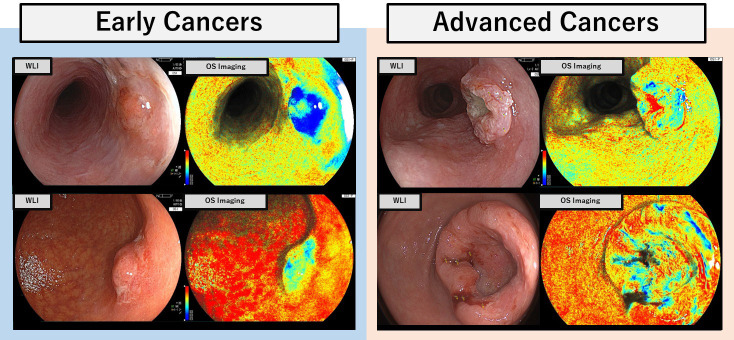
Oxygen saturation (OS) imaging of early and advanced upper gastrointestinal cancers.Gastric and esophageal metaplasia images of the early and advanced cancers are shown. OS imaging allowed relatively easy measurement of StO2 levels on tumor surfaces in early cancers. However, advanced cancers tend to be covered on adhered substances, such as blood and white coating, which can interfere with accurate measurements of tumor StO2 values.